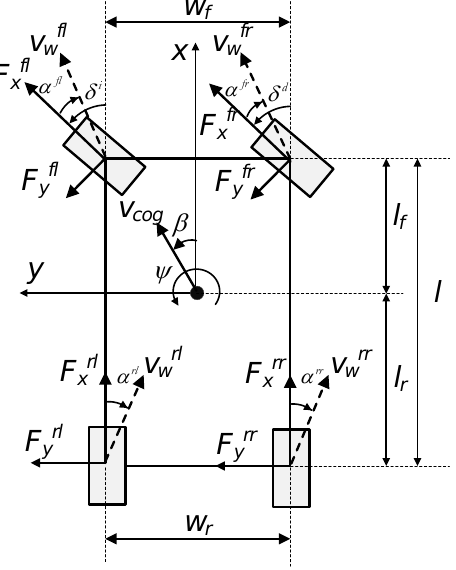
Figure 2. Four-wheel longitudinal-lateral model.